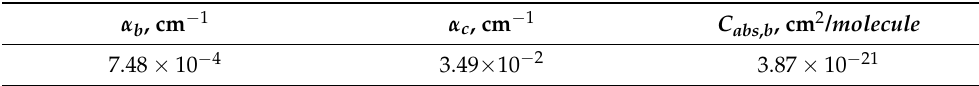
Equation (5) and data are given in Table